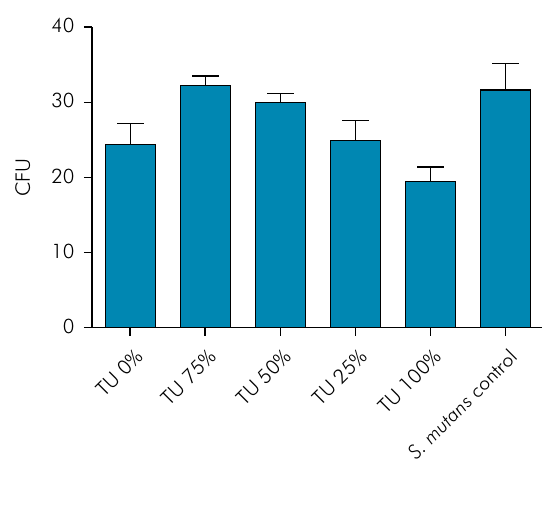
Figure 1. Colonies forming units (CFUs) in each experimental group and control group.